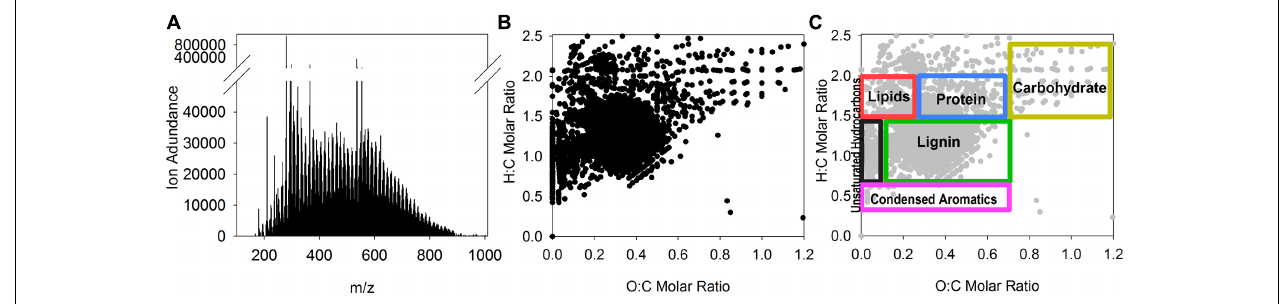
FIGURE 1 | Compound level evaluation of extracted tDOM. Fourier transform ion cyclotron resonance mass spectrometer was used to evaluate the composition of the extracted tDOM. The presented data include (A) FT-ICR mass spectra of extracted tDOM source showing the relative ion abundances of detected mass-to-charge ratios ( m/z s); (B) Van Krevelen diagram showing the hydrogen to carbon (H:C) and oxygen to carbon (O:C) molar ratio distributions of masses for which molecular formulas could be assigned (96% of detected m/z s); (C) Van Krevelen diagram of the same points shown in (B) overlaid with general compound class ranges described in Hockaday et al.,